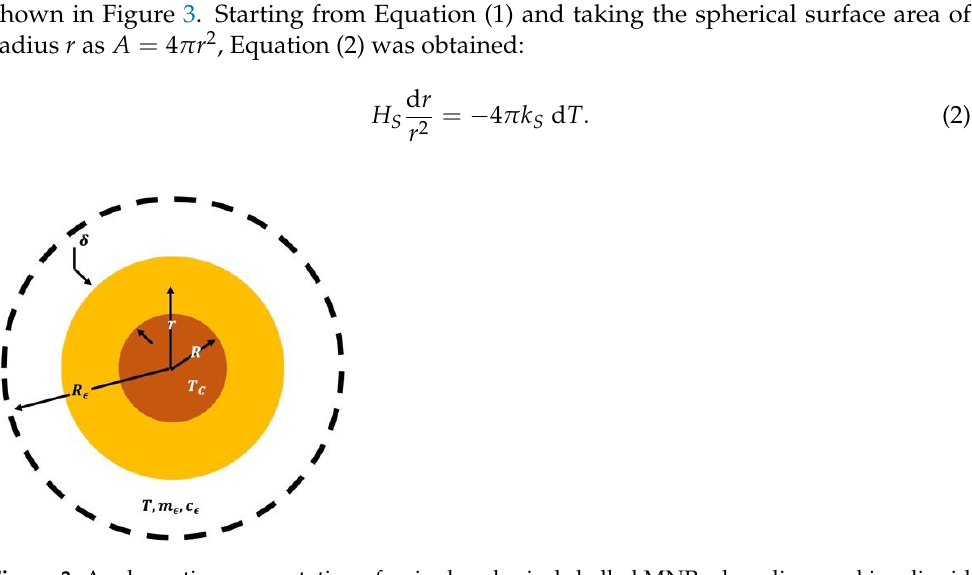
Figure 3. A schematic representation of a single spherical shelled MNP when dispersed in a liquid medium (surrounding environment) with an average nanoparticle concentration scaling of 3/4 π R 3 (cid:101) . By assuming the SSC of heat transfer with a constant thermal current ( H S ), Equation